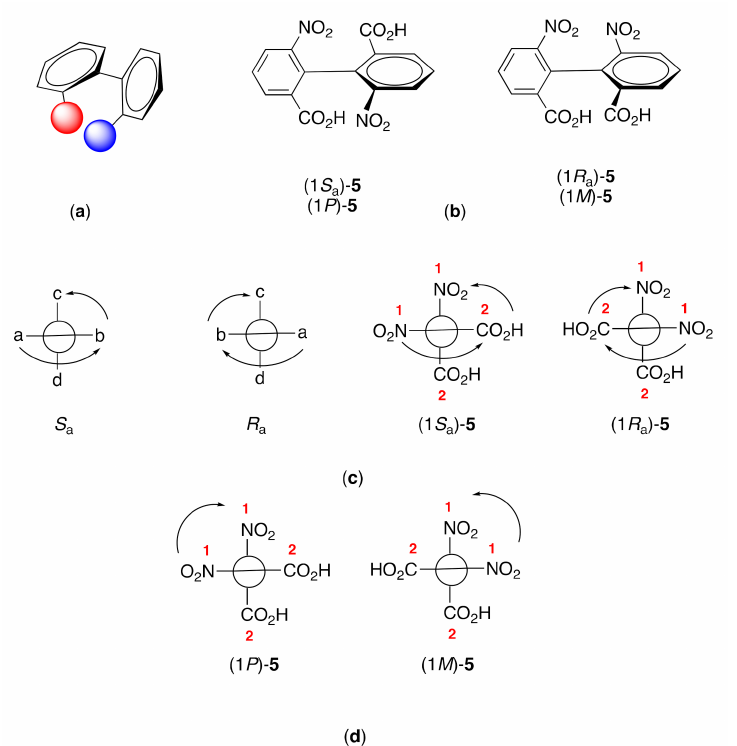
Figure 2. ( a ) Steric interactions between the red and blue substituents in biaryls can lead to atropiso- merism with the chiral axis being the interannular C–C bond; ( b ) the first atropisomeric compounds to be resolved were the enantiomers of 6,6 (cid:48) -dinitro-[1,1 (cid:48) -biphenyl]-2,2 (cid:48) -dicarboxylic acid; ( c ) the Cahn-Ingold-Prelog scheme can be extended to the nomenclature of axially chiral compounds using the usual priority rules for an „extended tetrahedron”; ( d ) but IUPAC recommends the use of P and M assigned using Cahn-Ingold-Prelog priorities as described in the